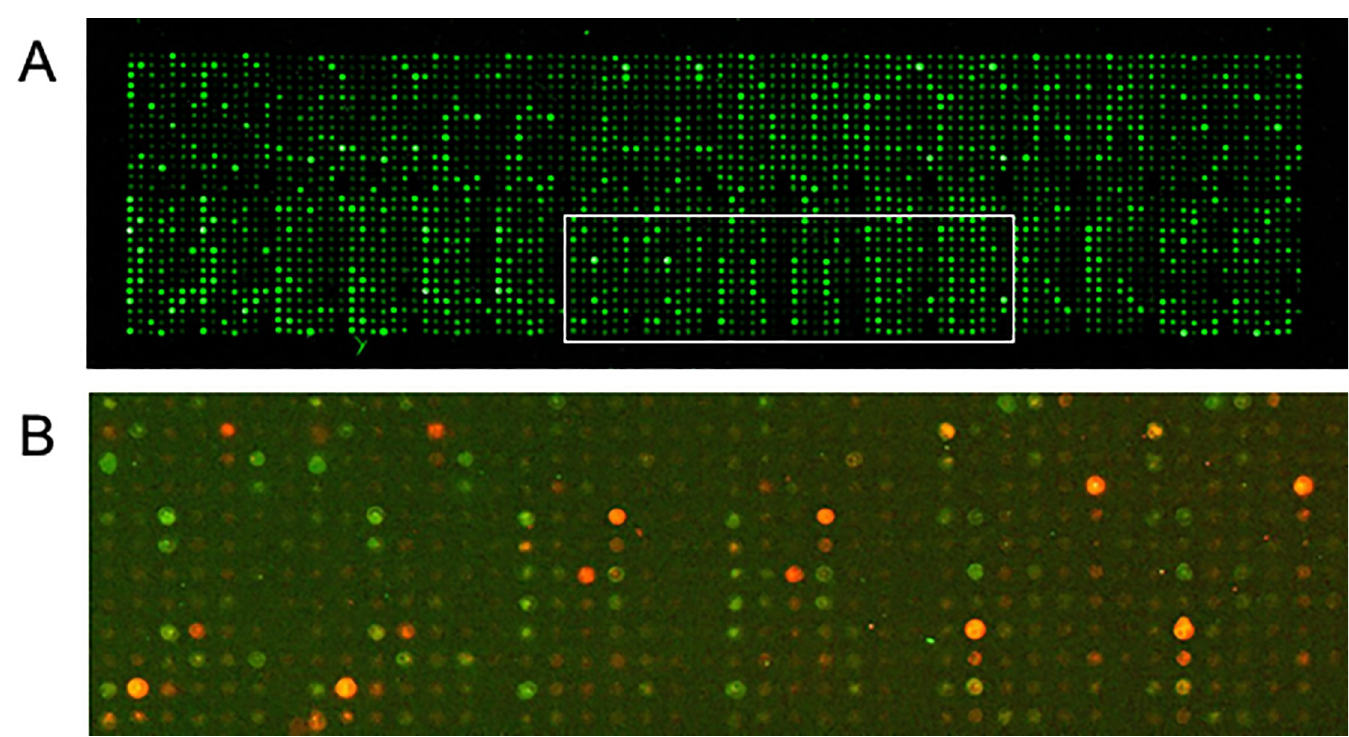
Fig 1. Microarrays. (A) Protein microarray with 1460 purified GST-fused C . jejuni proteins duplicated on a slide with 3,136 spots, including spots with purified GST and blank controls. Duplicate groupings are every 7 rows (oriented vertically). The microarray was probed with fluorescein-labeled anti-GST antibodies (green). ( B) A section of the protein microarray (corresponding to the boxed region in Fig 1A) probed with fluorescein-labeled anti-GST antibodies (green) and rabbit anti- C . jejuni antisera plus Cy5-labeled goat anti-rabbit IgG (red).